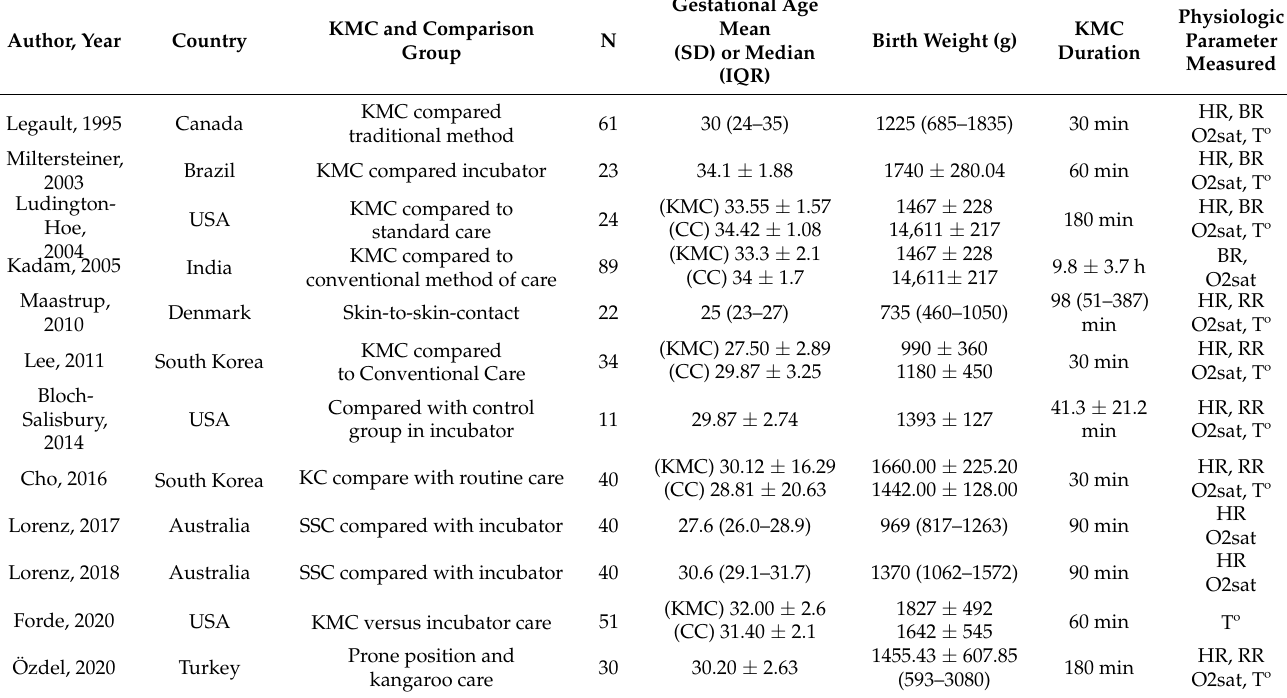
Table 1. Characteristics of the included